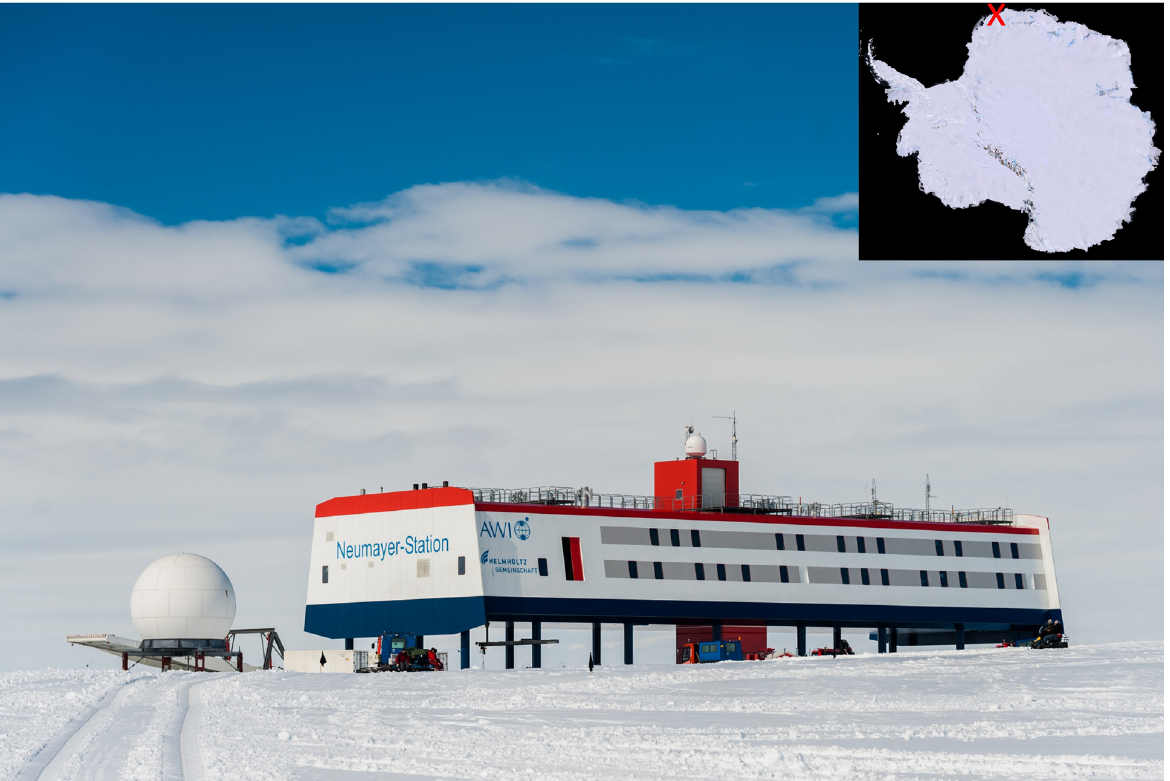
Figure 1 : Neumayer Station III of the Alfred Wegener Institute located at Atka Bay on the Ekström Ice Shelf. The location of Atka Bay is indica- ted with an ‘X’ on the inset Antarctica map. (Neumayer Station III image: Alfred Wegener Institute/Stefan Christmann. Inset Antarctic image: Landsat imagery courtesy of NASA Goddard Space Flight Center and U.S. Geological